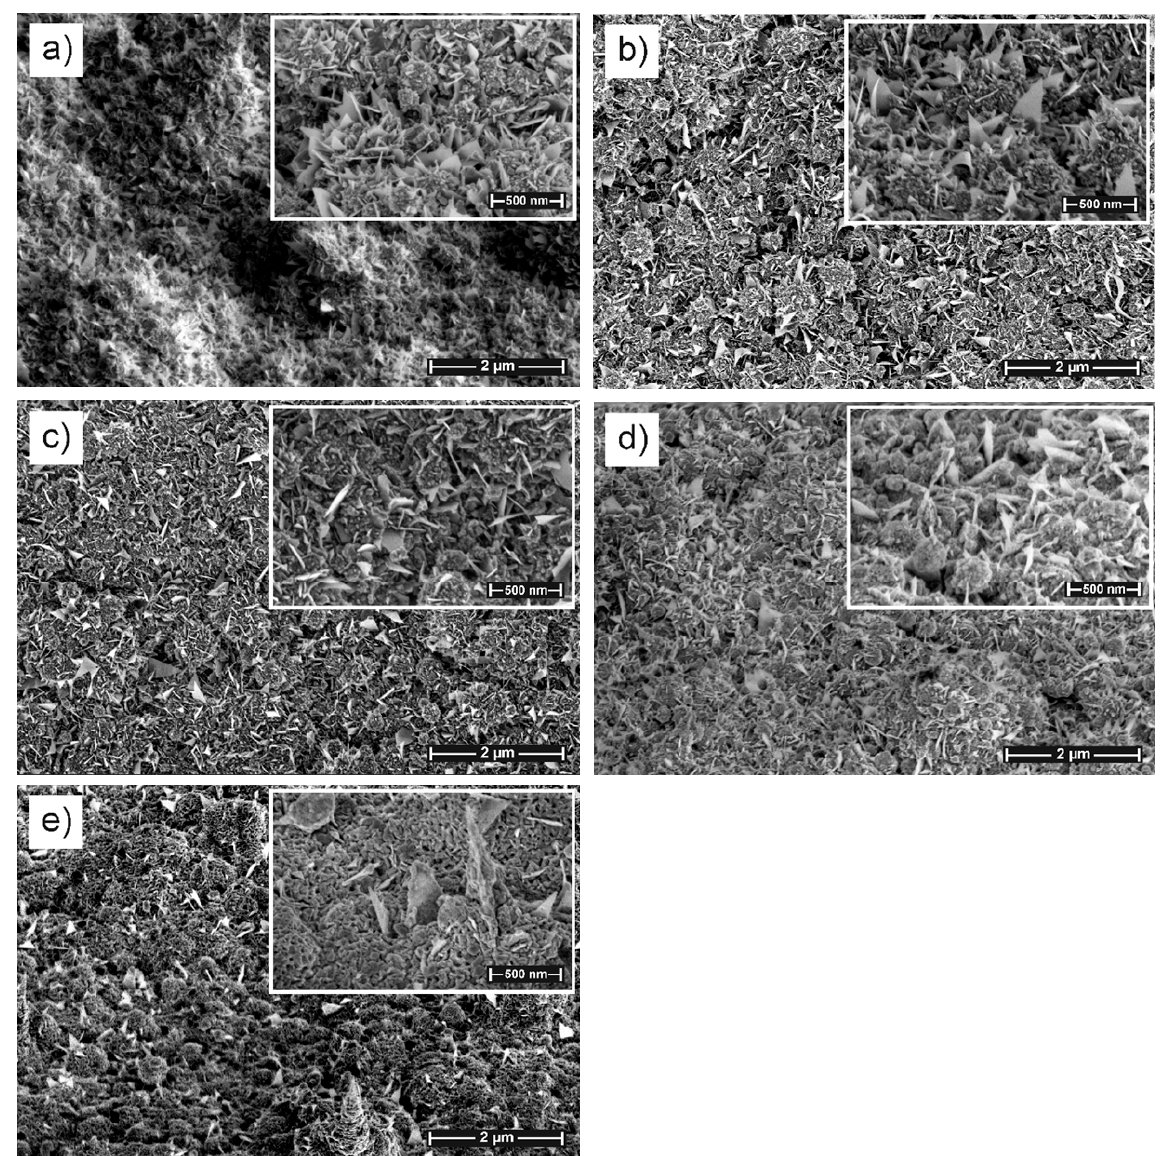
Figure 3. Morphology of Ni coatings deposited from ChCl: ethylene glycol bath with 1 mol dm − 3 NiCl 2 · 6H 2 O at 6 mA cm − 2 for 90 min at 70 °C before ( a ) and after 2 h heat-treatment at: 100 ( b ), 200 ( c ), 300 ( d ) and 400 °C ( e ).